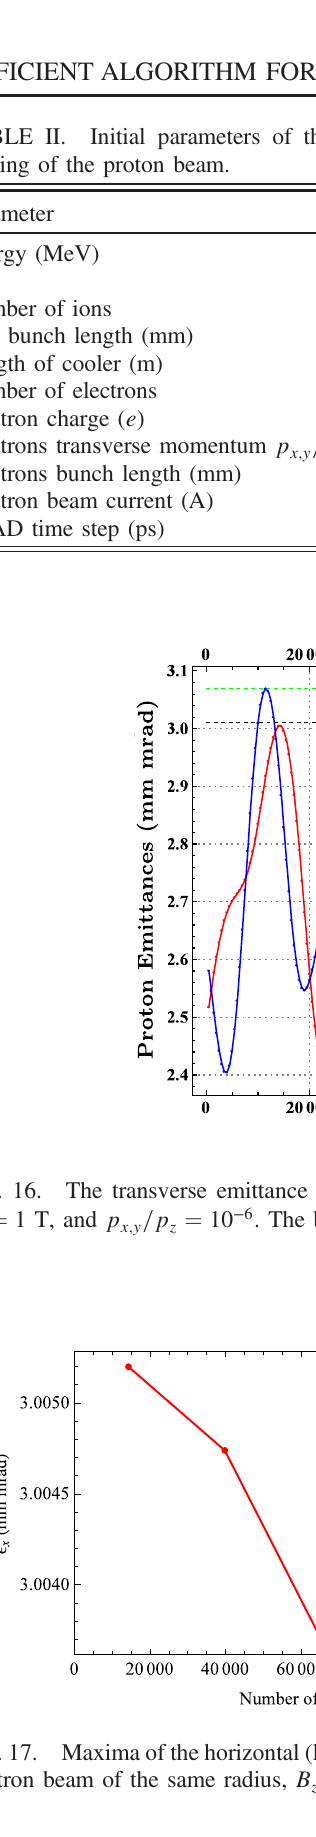
1 T, and p 10 − 6 . The decline of these maxima indicates =p z ¼ x;y z ¼